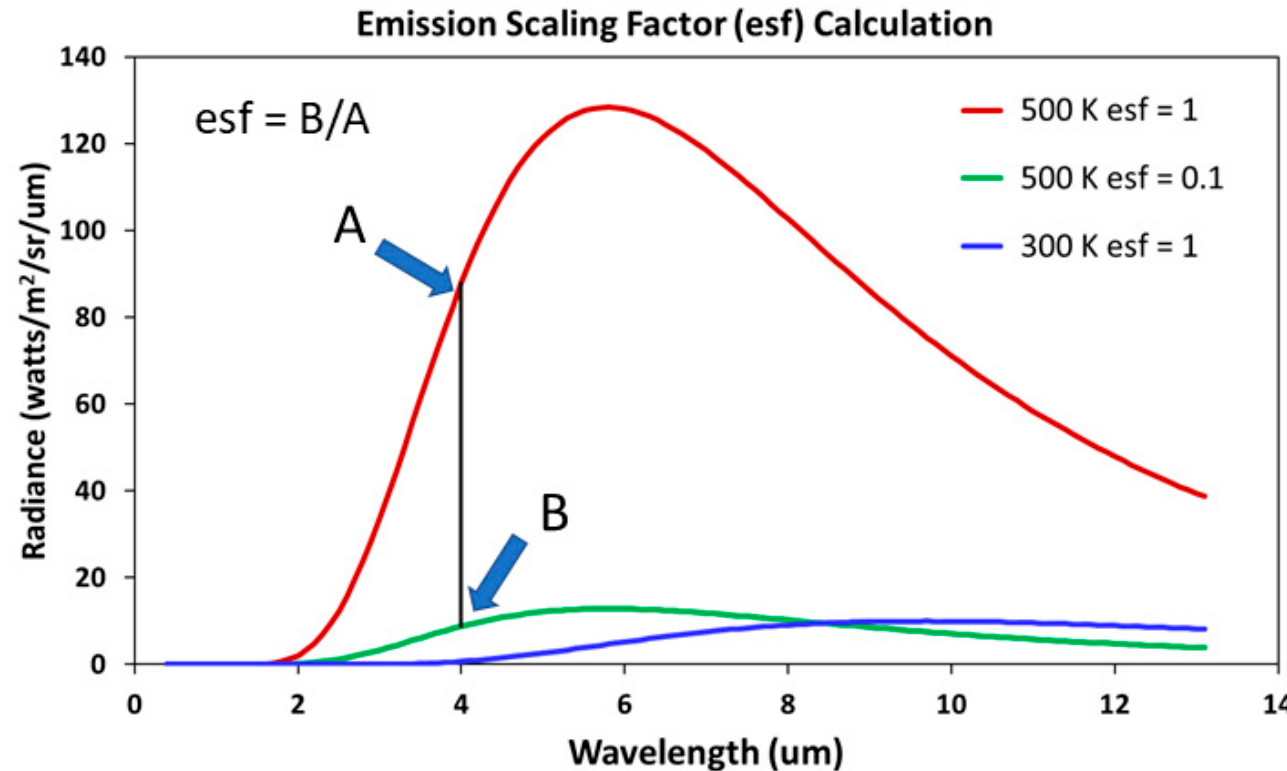
Figure 2. Calculation of the emission scaling factor (esf), which is multiplied by the pixel’s surface area to estimate the size of the infrared emitter.